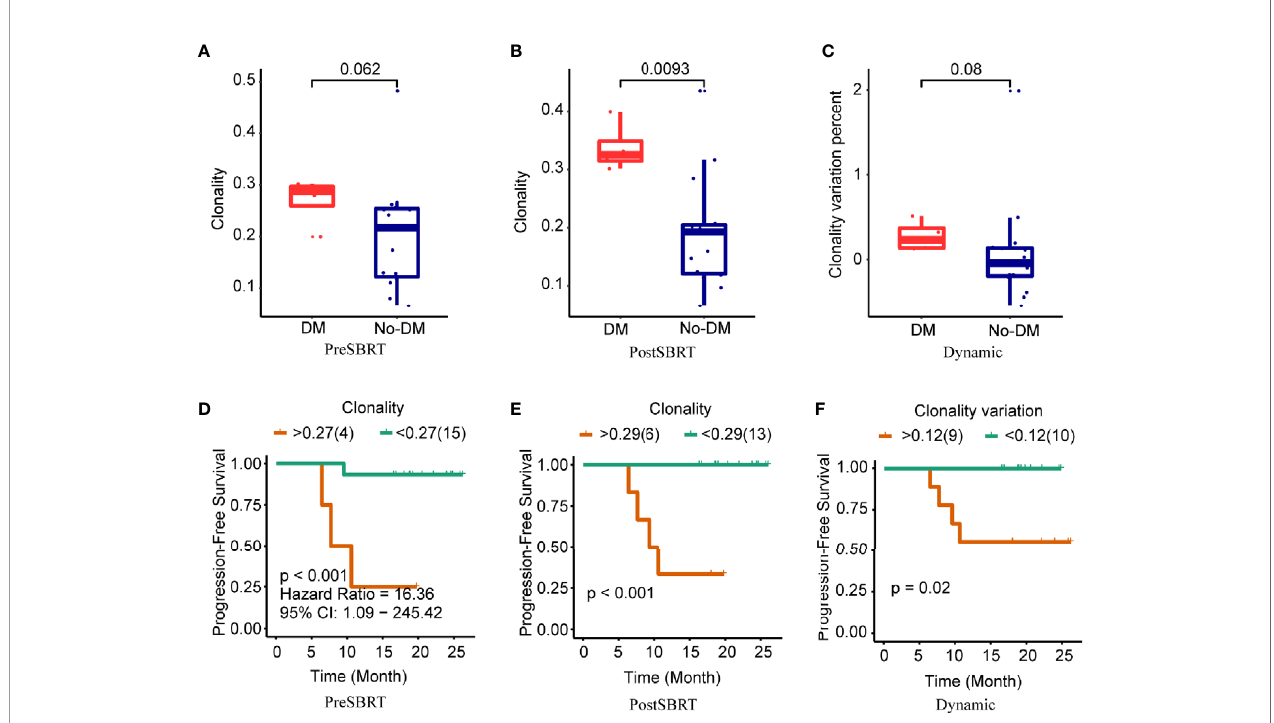
FIGURE 3 | Clonality and treatment outcomes. (A − C) Boxplots showing differences in clonality scores in baseline (before-SBRT) samples (A) ; in samples collected after SBRT (B) ; and in the difference in clonality between before and after SBRT [clonality after SBRT minus clonality before SBRT)/(clonality before SBRT)], according to whether patients developed metastases after SBRT (DM) or did not (no-DM). (D − F) Kaplan – Meier progression-free survival estimates according to clonality cut-off levels for samples obtained before SBRT (D) , after SBRT (E) , or the percent change in clonality from before to after SBRT (F) . Patients with high baseline clonality (i.e., >0.27) had signi fi cantly longer progression-free survival; patients with high post-SBRT clonality (>0.29) had longer progression-free survival; and patients with higher percent change in clonality (>0.12) had longer progression-free survival. P values are derived from unadjusted log-rank